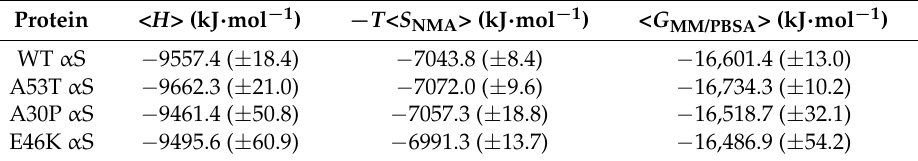
Table 1. Calculated average enthalpy ( H ), entropy ( TS ) and Gibbs free energy ( G ) values for the WT, A53T mutant, A30 P mutant and E46 K mutant type α S proteins in an aqueous solution